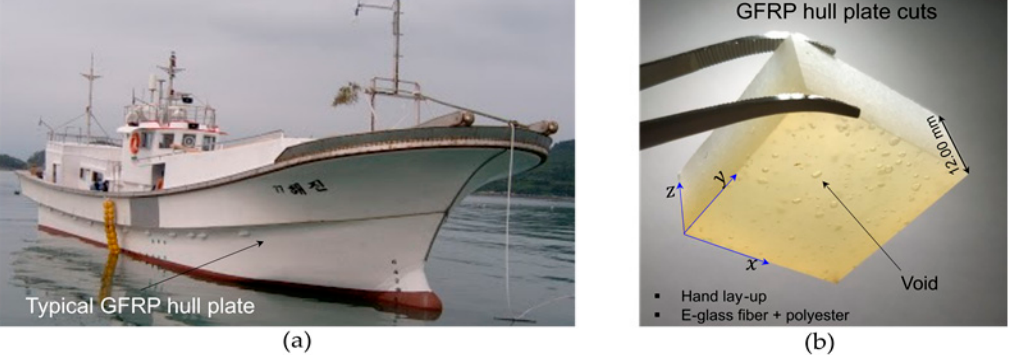
Figure 1. ( a ) Typical 15 m long fishing boat with a hull plate thickness of 10 mm [25]. ( b ) GFRP hull plate cuts with inner defects.